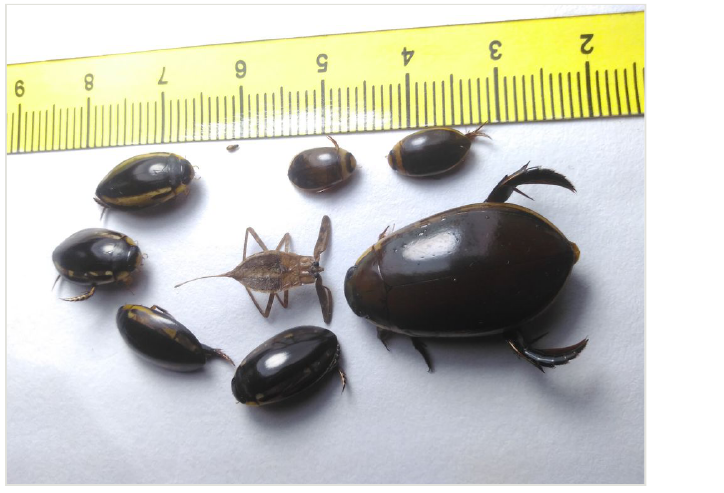
Figure 3. Dytiscidae image taken with handphone camera BALI_NS_2016_05 (large specimen: Cybister tripunctatus temnenkii ; two smaller beetles above the Cybister : Hydaticus fabricii ; four specimens on the left: Hydaticus bipunctatus conjungens ).